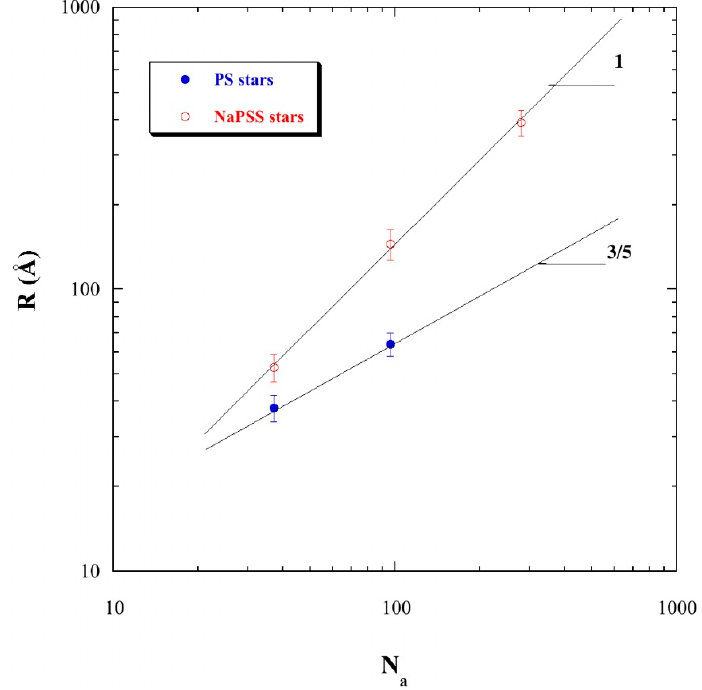
Figure 5. Mean radii of NaPSS stars ( R ) according to their arm degrees of polymerization ( N a ). For each star polyelectrolyte, R is obtained from the q 1 * value at c * ( R = π / q 1 *). A comparison with some precursor PS stars is also offered.